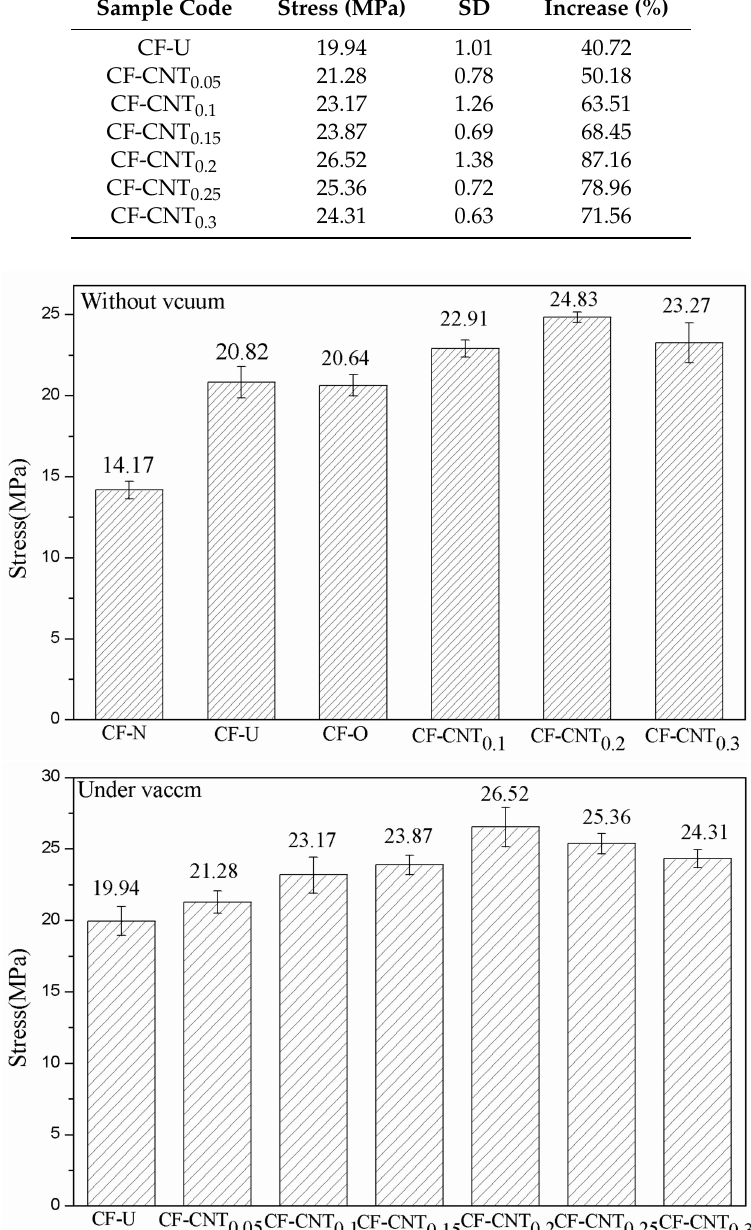
Figure 5. Bond strengths of single lap